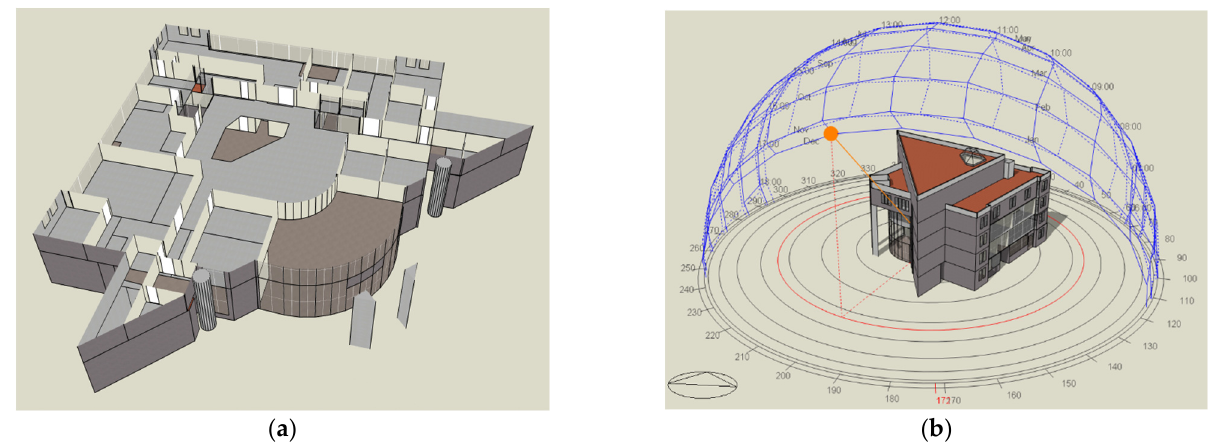
Figure 4. Three-dimensional Rendering for the ADF by DesignBuilder ( a ) First floor and ( b ) Model with annual sun-path.